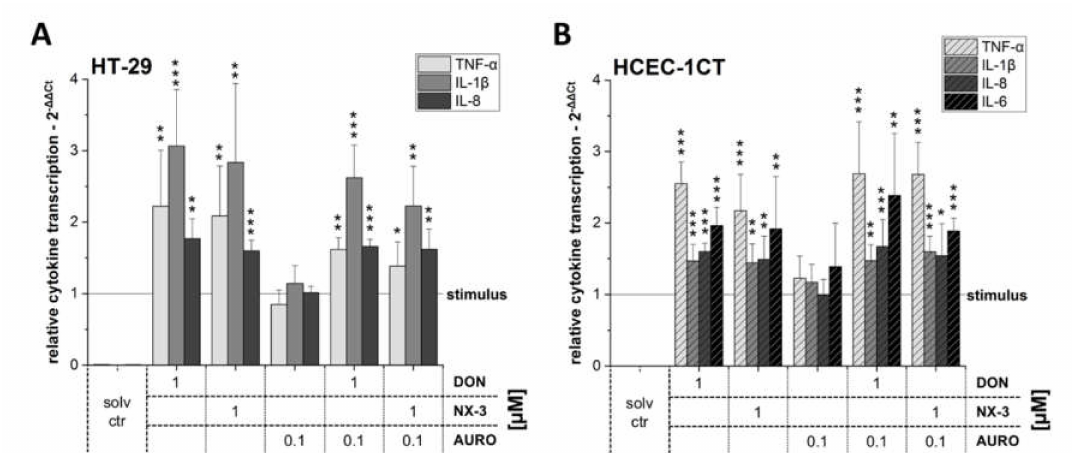
Figure 3. Relative gene transcription levels of TNF- α , IL-1 β , IL-8 and IL-6 in ( A ) HT-29 and ( B ) HCEC-1CT cells (calibrator was IL-1 β -treated solvent control, which was set to 1). Cells were preincubated with the compounds (DON, NX-3, AURO and their combinations) for 2 h followed by a 3 h IL-1 β challenge (25 ng / mL). Relative transcript levels were measured with qRT-PCR. Data are expressed as mean values ± SD normalized to IL-1 β -treated solvent control samples of at least five independent experiments. One percent DMSO and 1% water (LC–MS grade) served as solvent control. Significant di ff erences to IL-1 β -stimulation, calculated with two-sample t -test, are indicated with * ( p < 0.05), ** ( p < 0.01) and *** ( p <